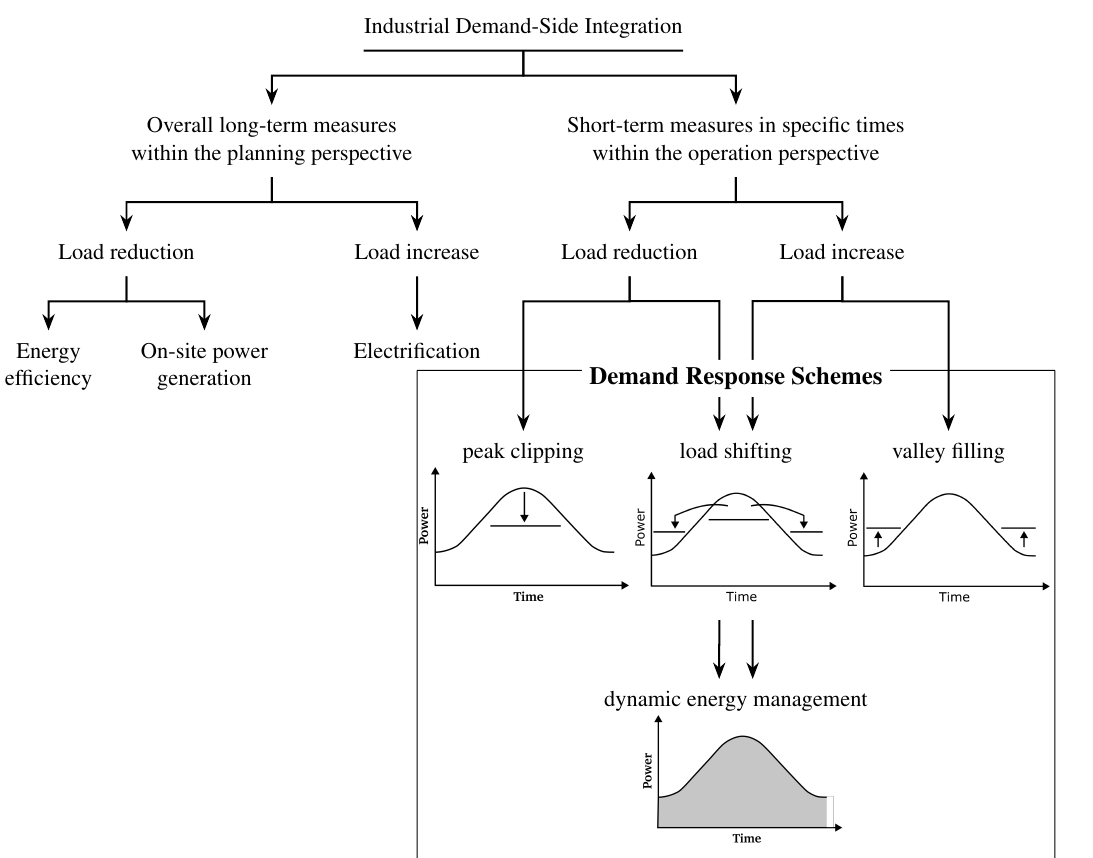
Figure 1. Classification of Industrial Demand-Side Integration based on load shaping objectives according to [21,25].